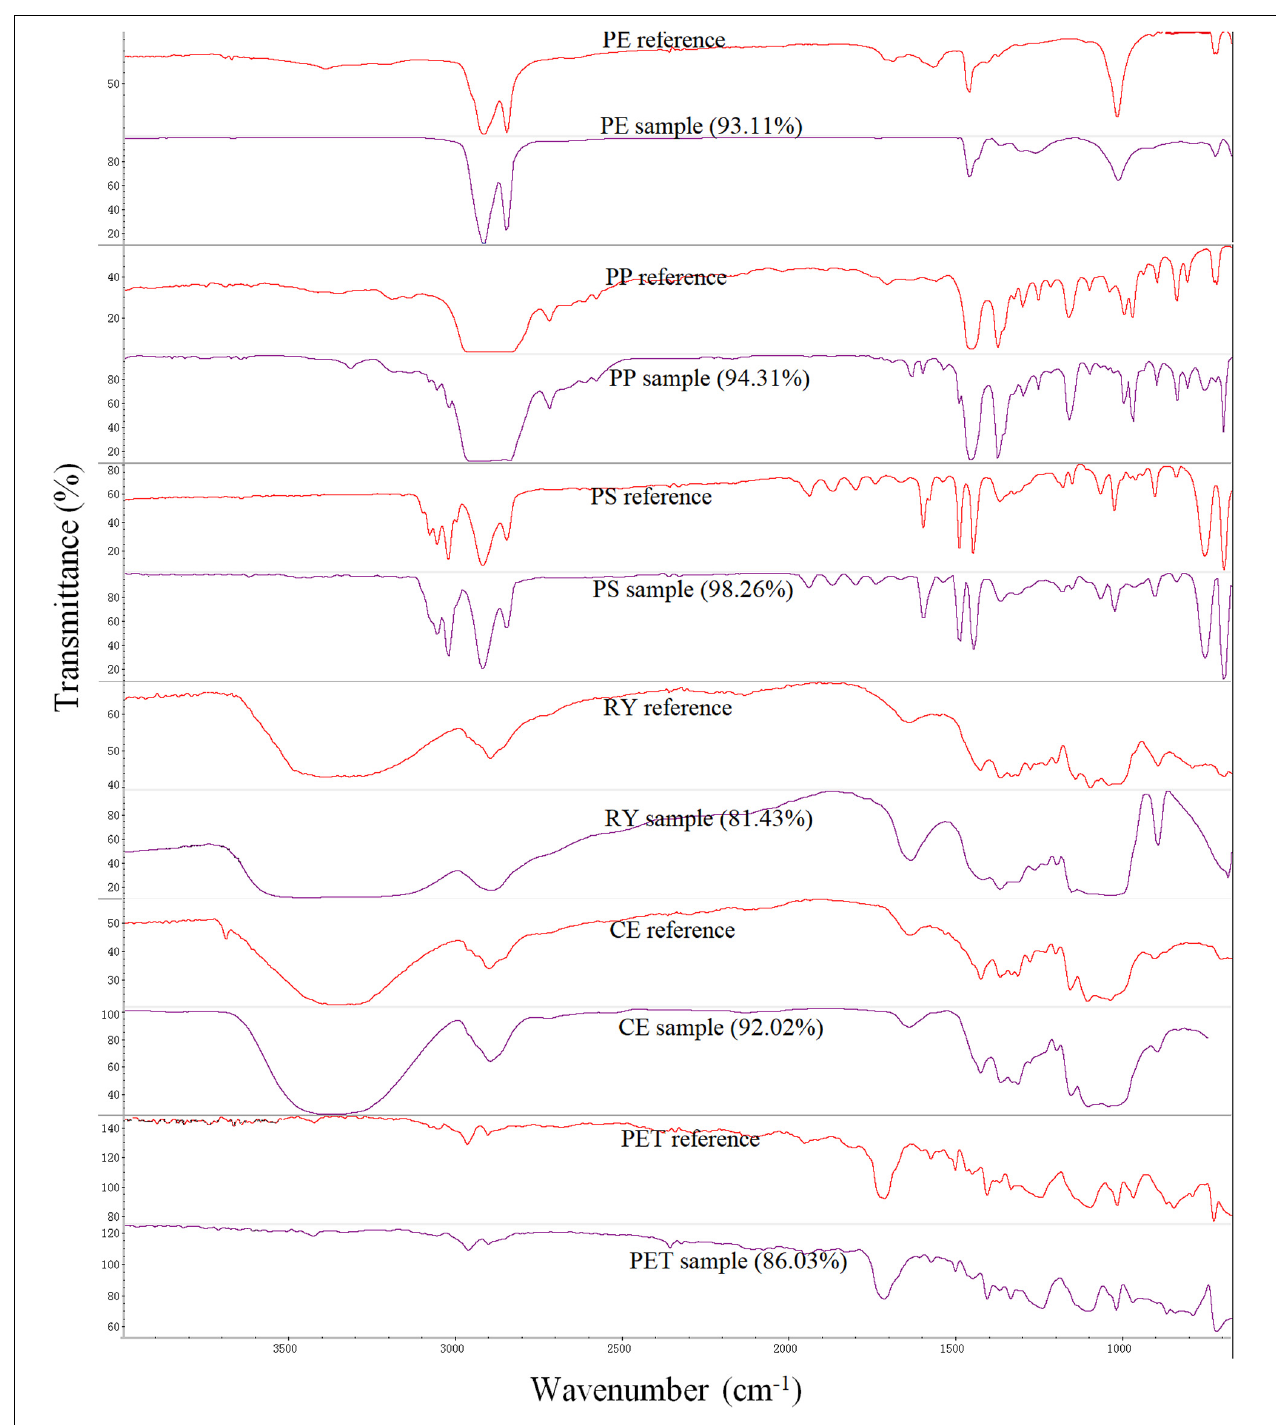
FIGURE 4 | Typical polymer spectra observed by micro-Fourier transform infrared spectrometer (numbers in brackets were the matching degree).